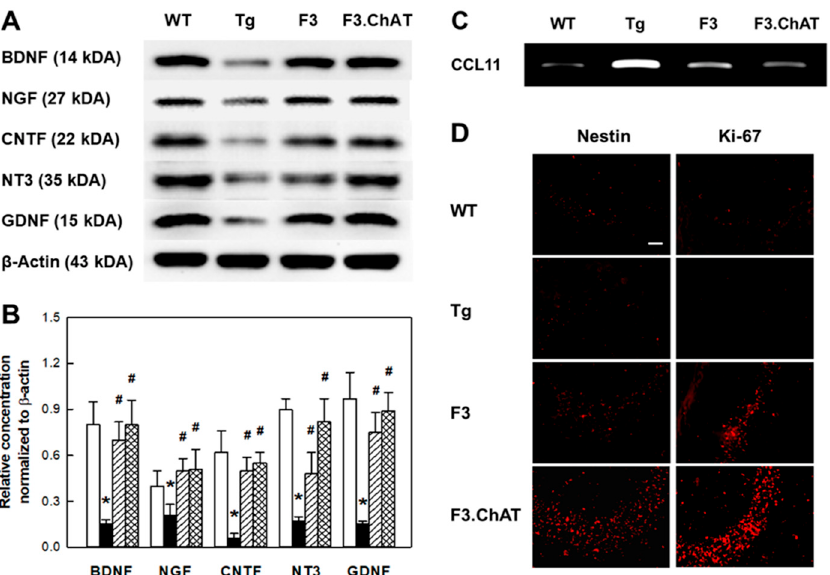
Figure 5. Production of growth and neurotrophic factors, expression of CCL11, and host stem cell proliferation in the brain of wild-type (WT) and APPswe/PS1dE9 transgenic (Tg) mice transplanted with F3 or F3.ChAT neural stem cells. ( A , B ): Growth and neurotrophic factor production. White bars: WT mice, black bars: Tg mice, shaded bars: Tg mice transplanted with F3 cells, checked bars: Tg mice transplanted with F3.ChAT cells. ( C ): CCL11 (a chemokine known as eotaxin) expression. ( D ): Representative findings of host neural stem cells (nestin-positive) and proliferating cells (Ki-67- positive) in the hippocampus of WT and Tg mice. Bar = 20 μ m. * Significantly different from WT mice ( p < 0.05). # Significantly different from Tg mice ( p < 0.05).